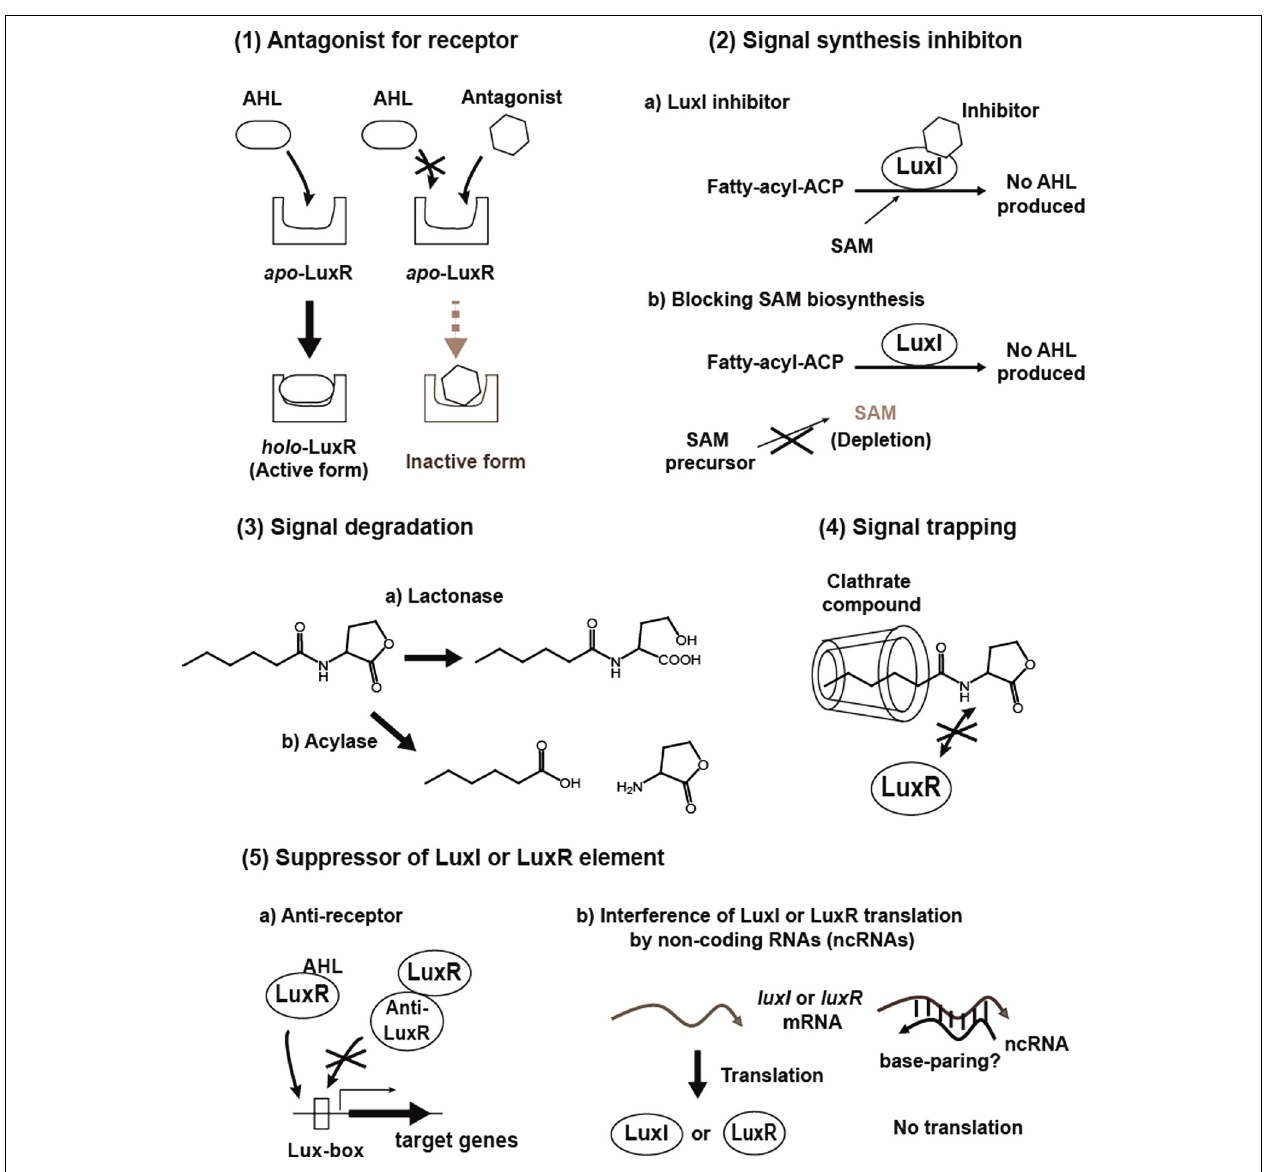
FIGURE 2 | Proposed methods forAHL quorum sensing